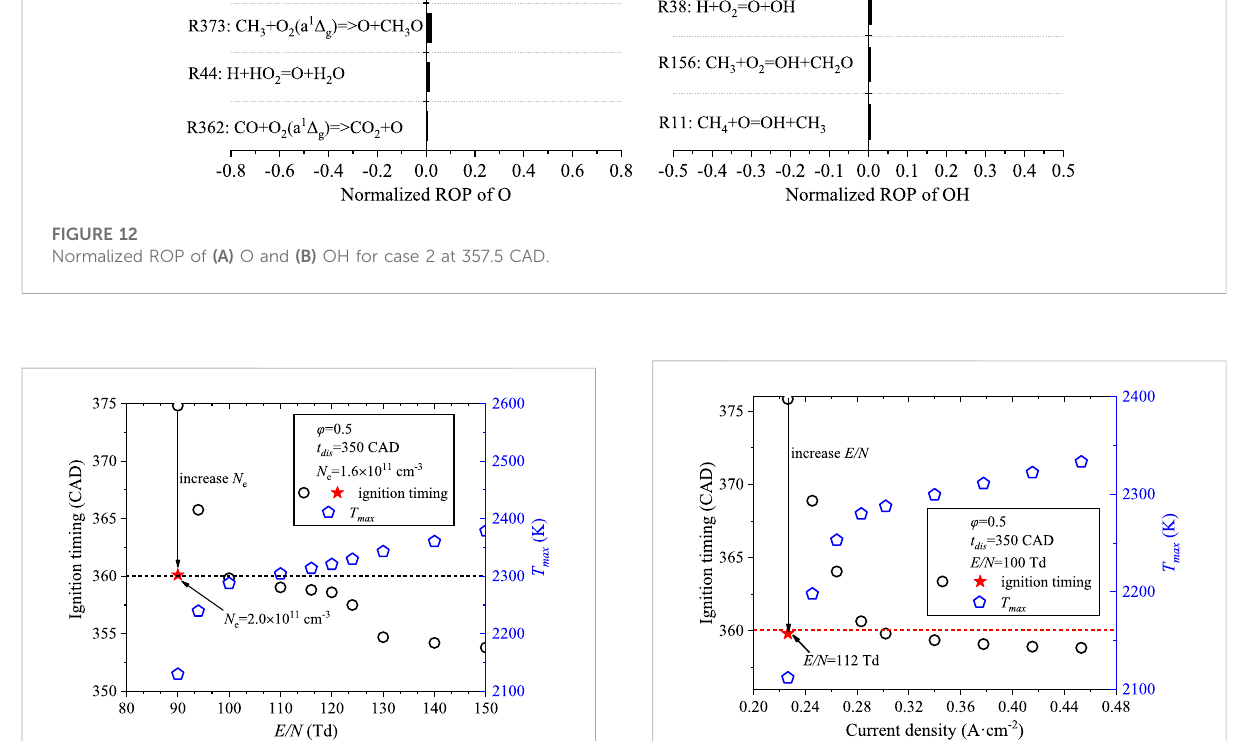
FIGURE 14 Ignition timing and maximum combustion temperature as a function of current